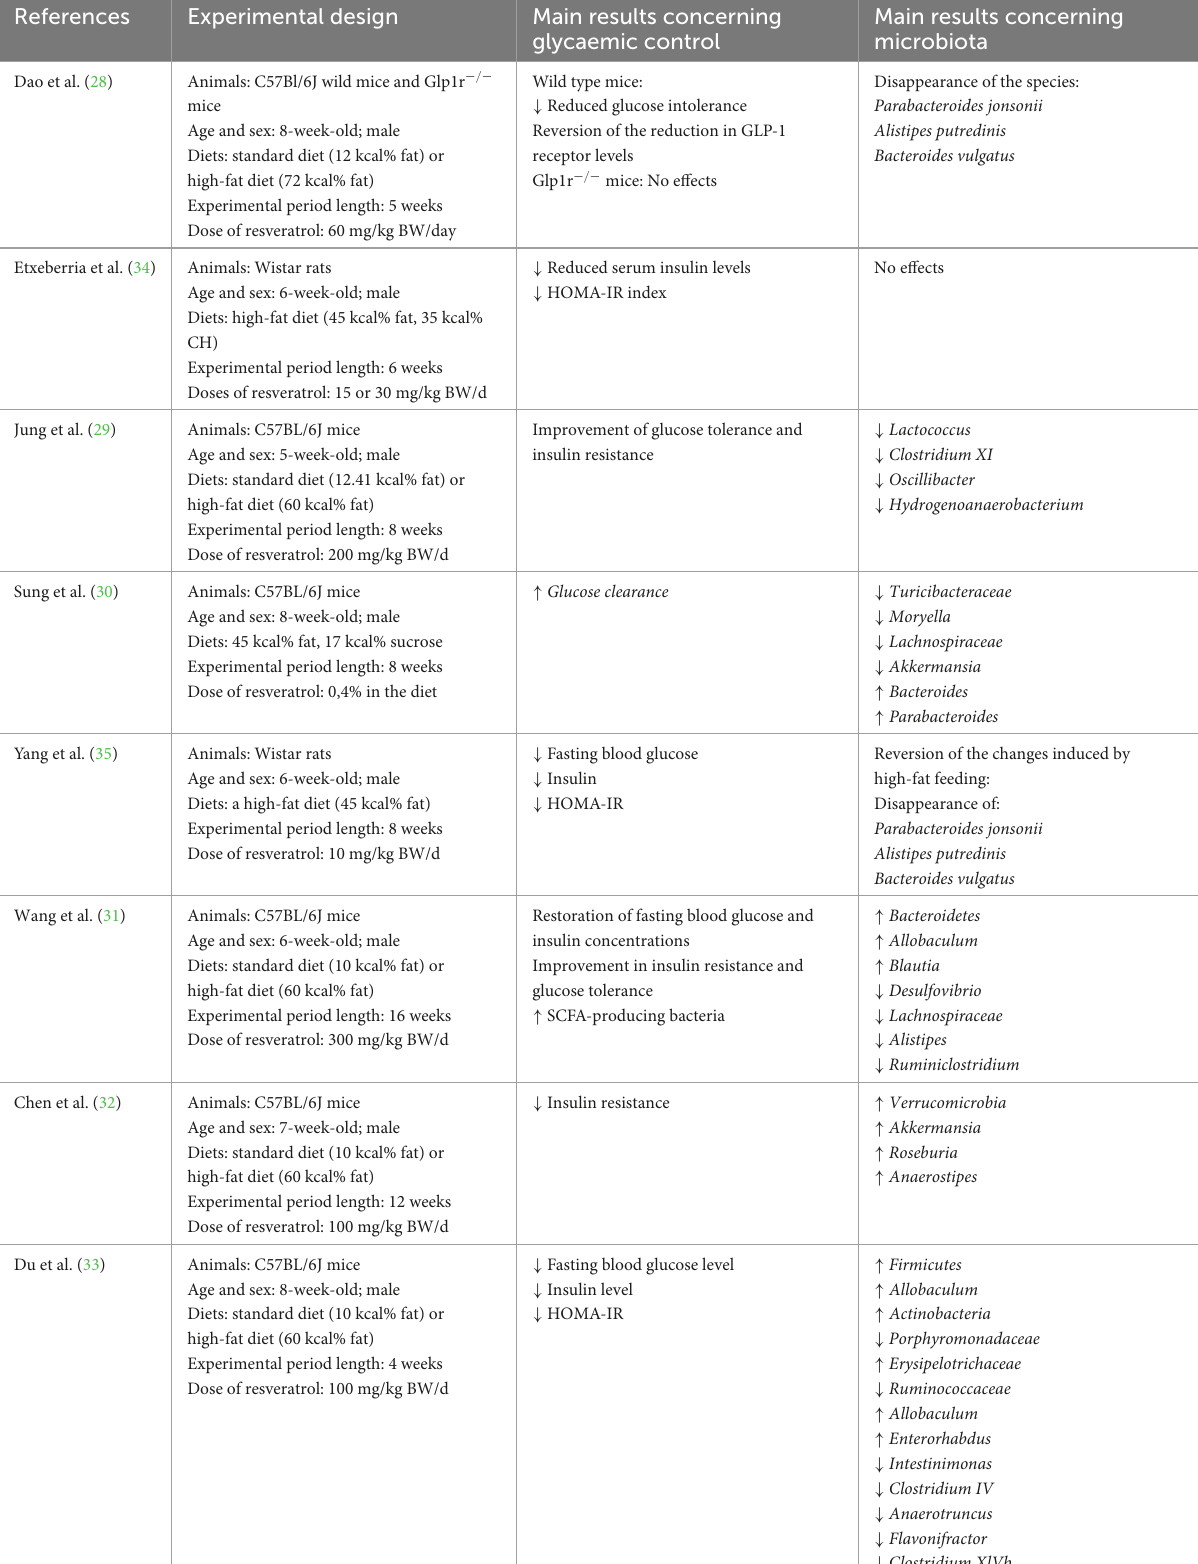
TABLE 1 Effects of resveratrol administration on glycaemic control and gut microbiota